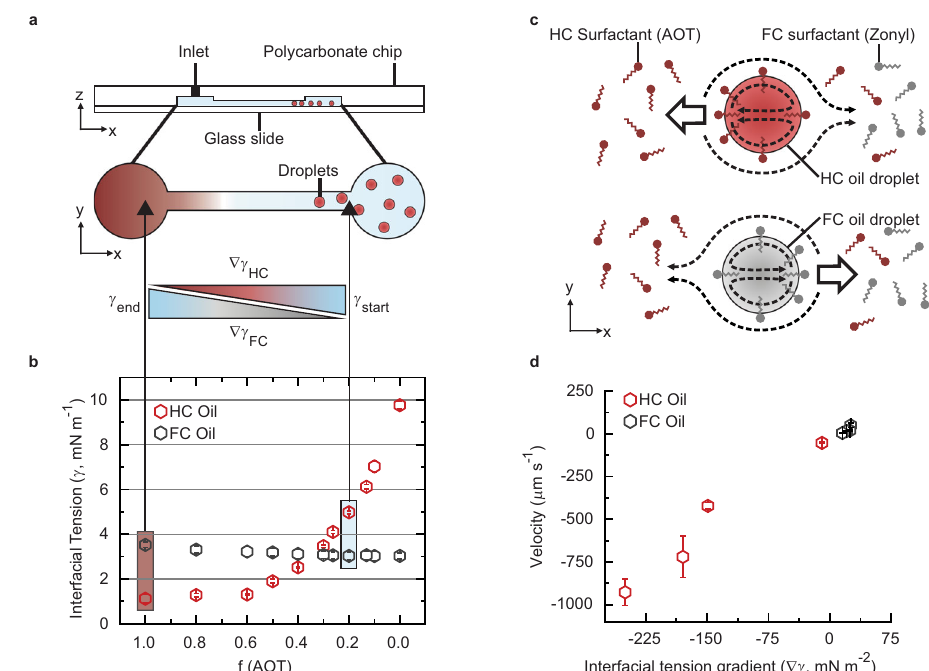
Fig. 1 Chemotactic motion of single-phase emulsion droplets within a binary surfactant gradient of constant overall concentration. a Schematic of the micro fl uidic channel used in these experiments, where droplets placed inside the channel experience a laminar interfacial tension gradient upon addition of a surfactant solution with different composition to the open end of the channel; b interfacial tensions of the two different HC and FC droplet oils (HC: 1:3 mixture of decane and bromohexane; FC: methoxyper fl uorobutane) inside an overall 1 wt.% binary surfactant solution of AOT and Zonyl, displayed as a function of the fraction of AOT, f (AOT), where the other fraction is Zonyl; c schematic diagram of Marangoni-type fl uid fl ow fi elds (dashed lines) induced by a lateral interfacial tension gradient at the droplet interface and the resulting direction of chemotactic motion of the droplets with respect to the surrounding liquid (large arrow). The different surfactant densities at the droplet interface are used to schematically represent the induced interfacial tension gradient at the droplet interface.; d experimentally determined velocities of droplets stabilized by 1 wt.% solutions of AOT and Zonyl in different compositions, upon addition of a pure 1 wt.% AOT solution to the open end of the microchannel, plotted against the estimated interfacial tension gradient from interfacial tension measurements; a negative velocity re fl ects a droplet motion towards the open end of the channel and a positive velocity corresponds to a movement away from the added surfactant solution; error bars re fl ect > 5